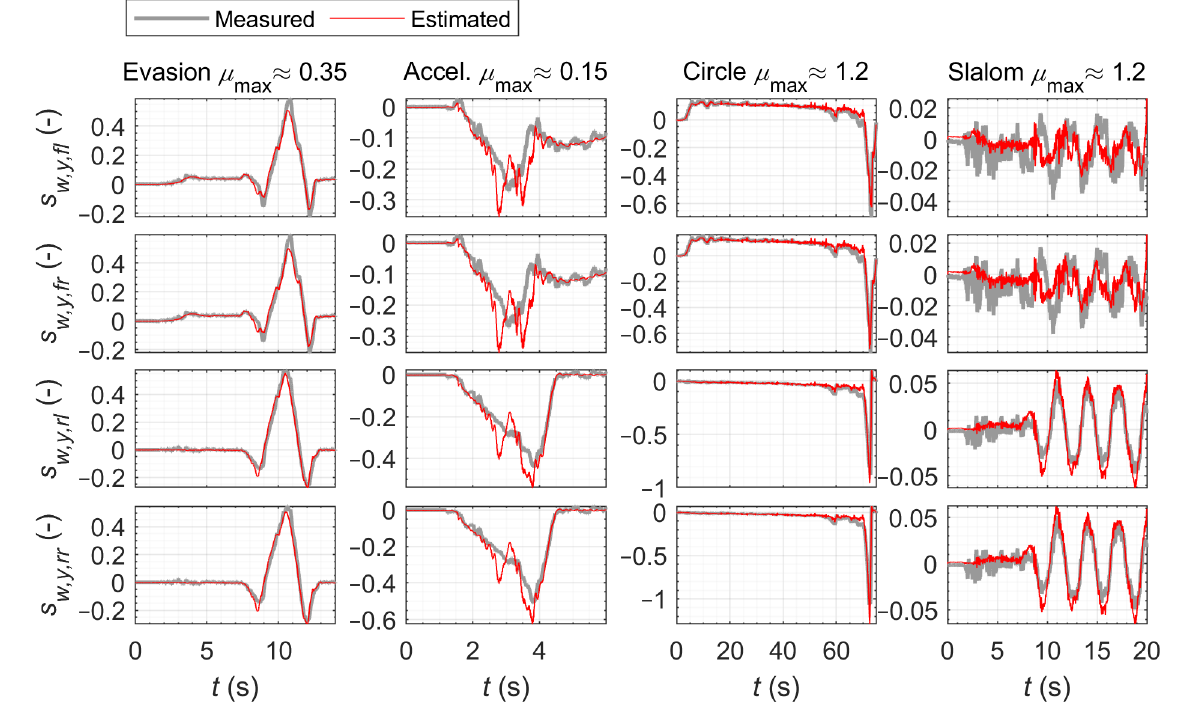
Figure A6. Test data: measured and estimated lateral tire slip.